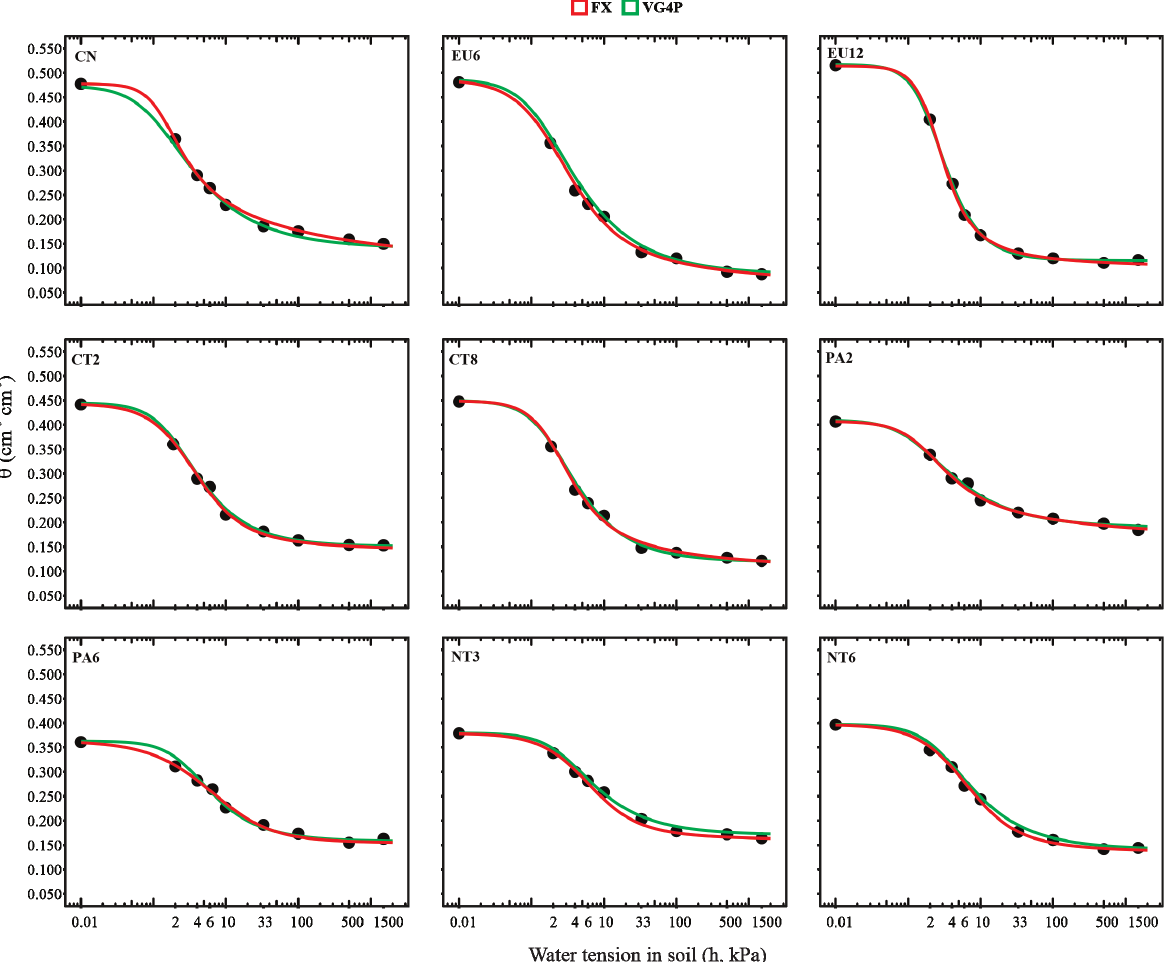
Figure 4. Soil water retention curves in different adjustment models (Fredlung-Xing = FX and van Genuchten-4P = VG4P) and management systems: NC - Native Cerrado, EU6 - Six year Eucalyptus, EU6 - Twelve years Eucalyptus, PA2 - Pasture (two years), PA6 - Pasture (six years), CT2 - Conventional tillage (two years), CT8 - Conventional tillage (eight years), NT3 - No-tillage (three years), NT6 - No-tillage (six